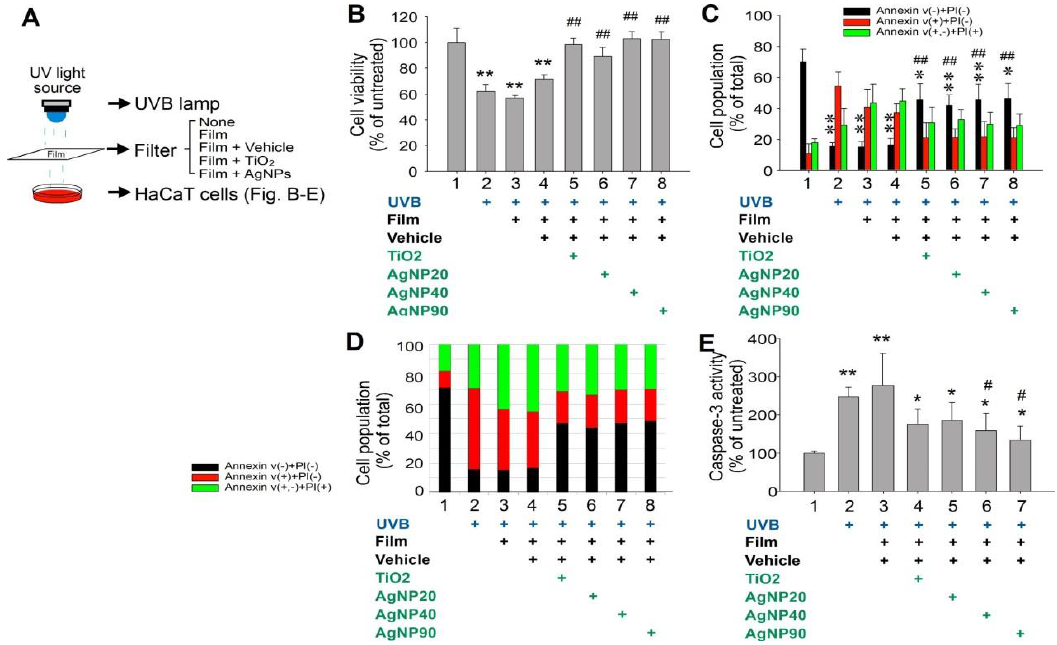
Figure 2. AgNPs protect HaCaT keratinocytes from UVB damage. Experiment setting ( A ). TiO 2 NPs and AgNPs mediated the rescue of UVB-induced cell death among human immortalized keratinocyte HaCaT cells (UVI 6 for 20 min (135.9 mJ/cm 2 ) at 1 mg/cm 2 ), according to XTT ( B ), flow cytometry ( C , D ) (annexin V and propidium iodide (PI) staining), and caspase-3 ( E ) assays. Black columns indicate annexin V − /PI − (surviving cells), red columns indicate annexin V + /PI − (early stage of cell death), and green columns represent PI + (late stage of cell death). Groups without UVB exposure (UVB ( − ) untreated control) were normalized to 100% ( B , E ). The total cell population of each group was normalized to 100% ( C , D ). n = 6 (three experiments with two replicates). * p < 0.05, ** p < 0.01 vs. UVB ( − ) groups; # p < 0.05, ## p < 0.01 vs. vehicle groups. UVB, ultraviolet